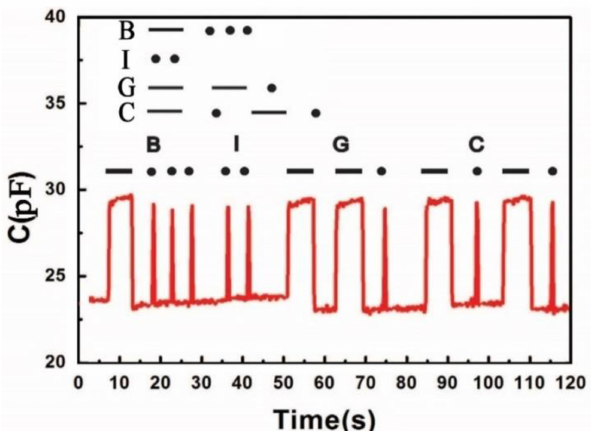
Figure 9. Time dependent capacitance of the prepared flexible sensor by knocking the sensor with finger to create Morse code. The word of “BIGC” which means Beijing Institute of Graphic Communication was yielded by converting the capacitance curve wave into Morse